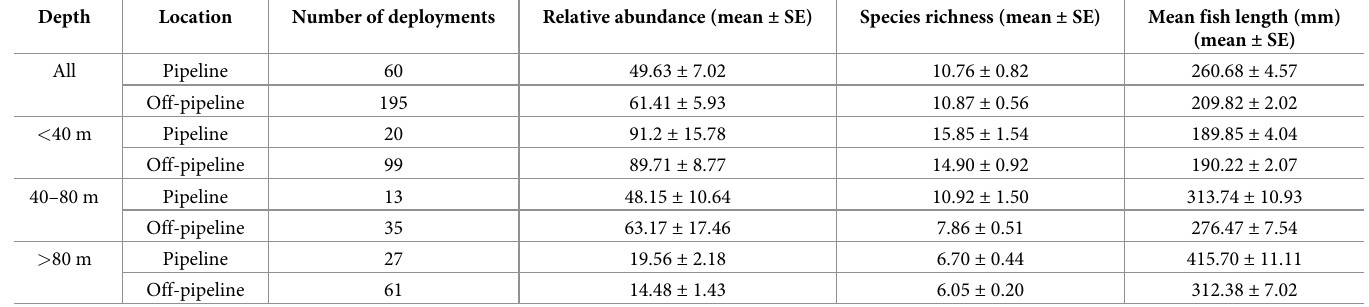
Table 2. The mean relative abundance (sum of MaxN), species richness (# species) and mean fish length (fork length; mm) of fish recorded on stereo-BRUV deploy- ments on and off-pipeline. Depth